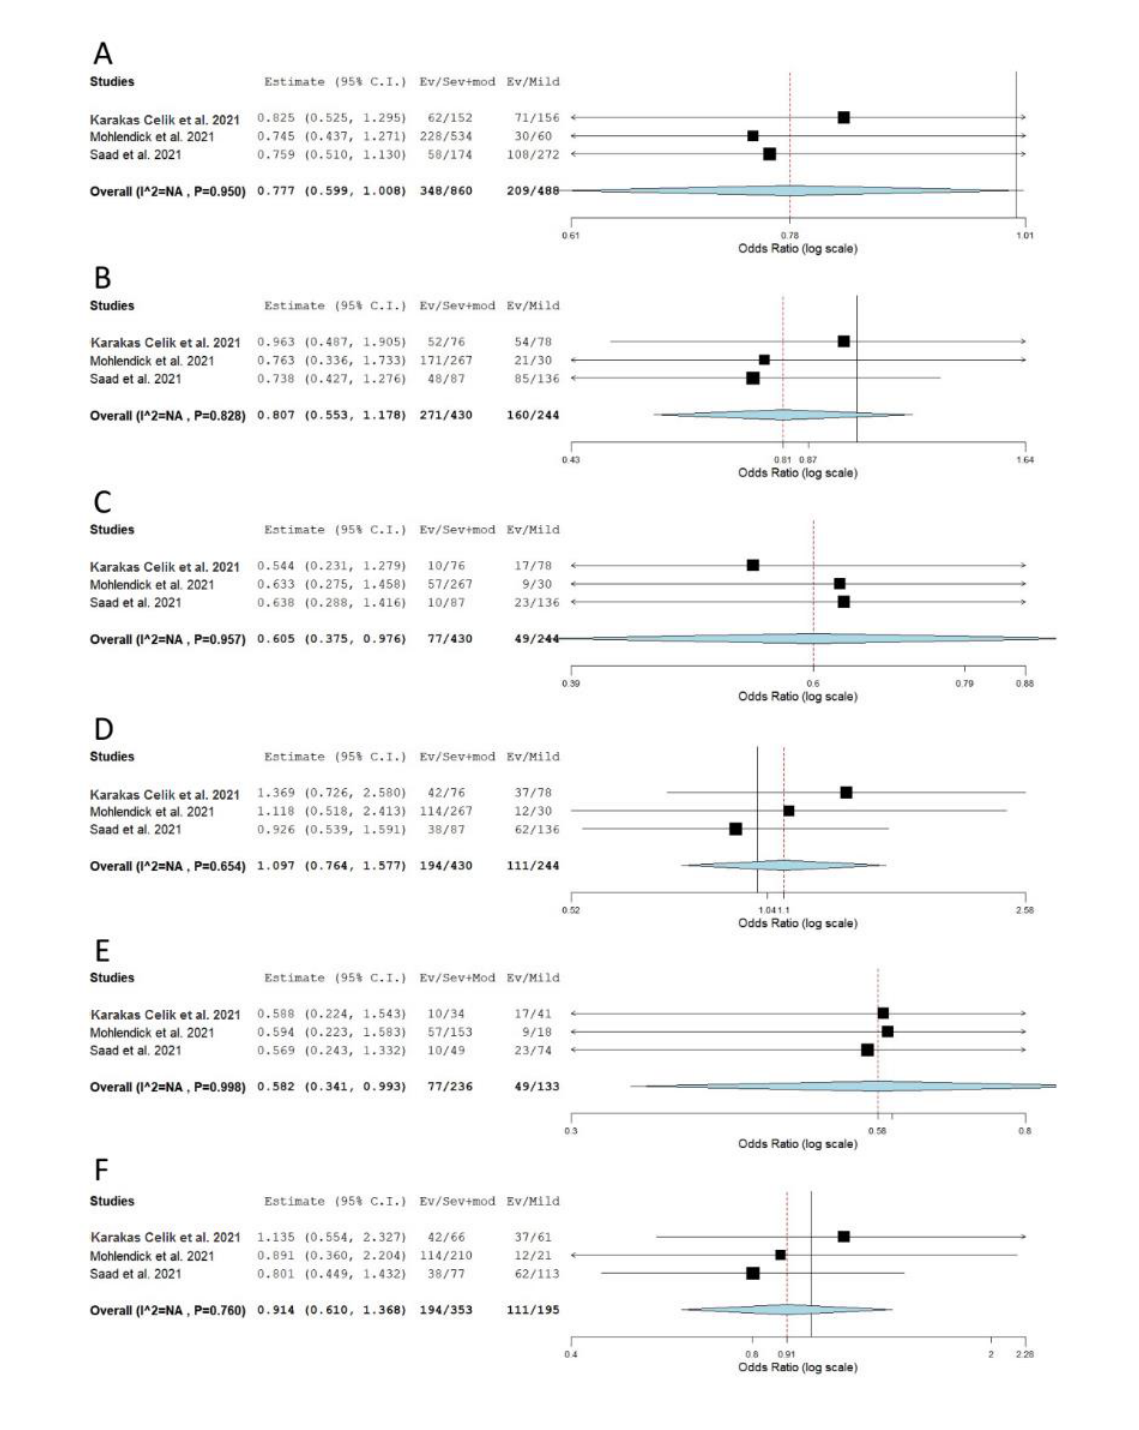
Figure 2: Meta-analysis of the association between rs1799752 in ACE1 and COVID-19 severity: com- parison severe+moderate vs. mild. A ) allelic model; B ) dominant model; C ) recessive model; D ) over- dominant model; E ) II vs. DD; F ) DI vs. DD. The results of the included studies presented as ORs, with 95 % CI, and the overall effect with 95 % CI are shown in the forest plot. P values given are derived from heterogeneity